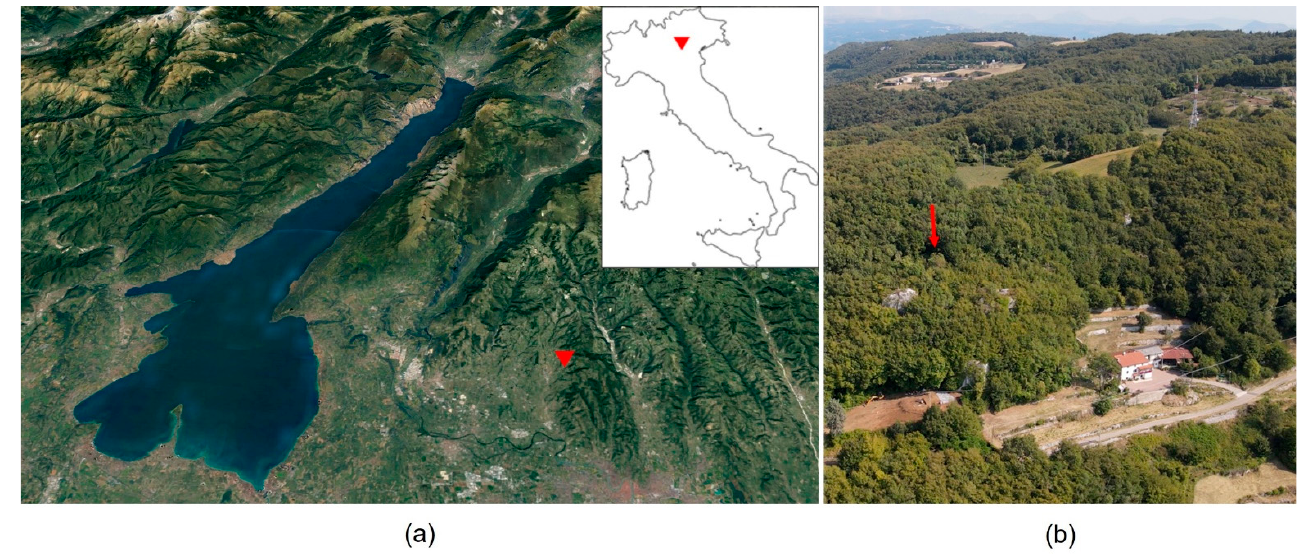
Figure 1. Colombare di Negrar: Location map. ( a ) The Garda Lake area in Italy; the basemap is a modified satellite image provided by GoogleEarth™; ( b ) aerial photograph of the site in 2021 marked by the red arrow (photo by Angelo Cimarosti—Archeoreporter; September 2021).